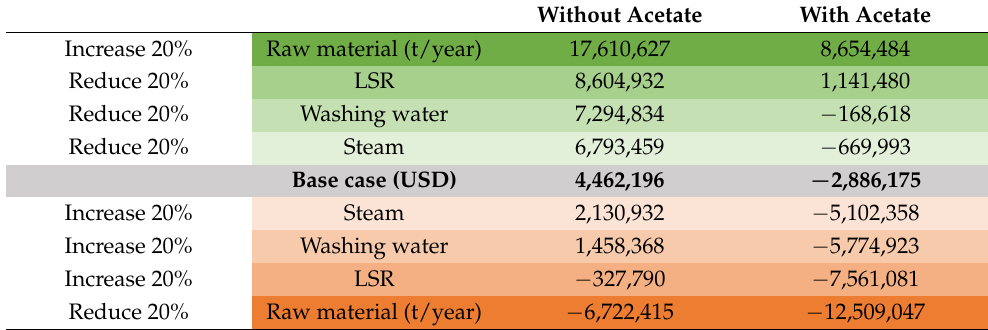
Table 6. The sensitivity assessment for the selected variables in the EUC scenario. Values of NPV in USD.